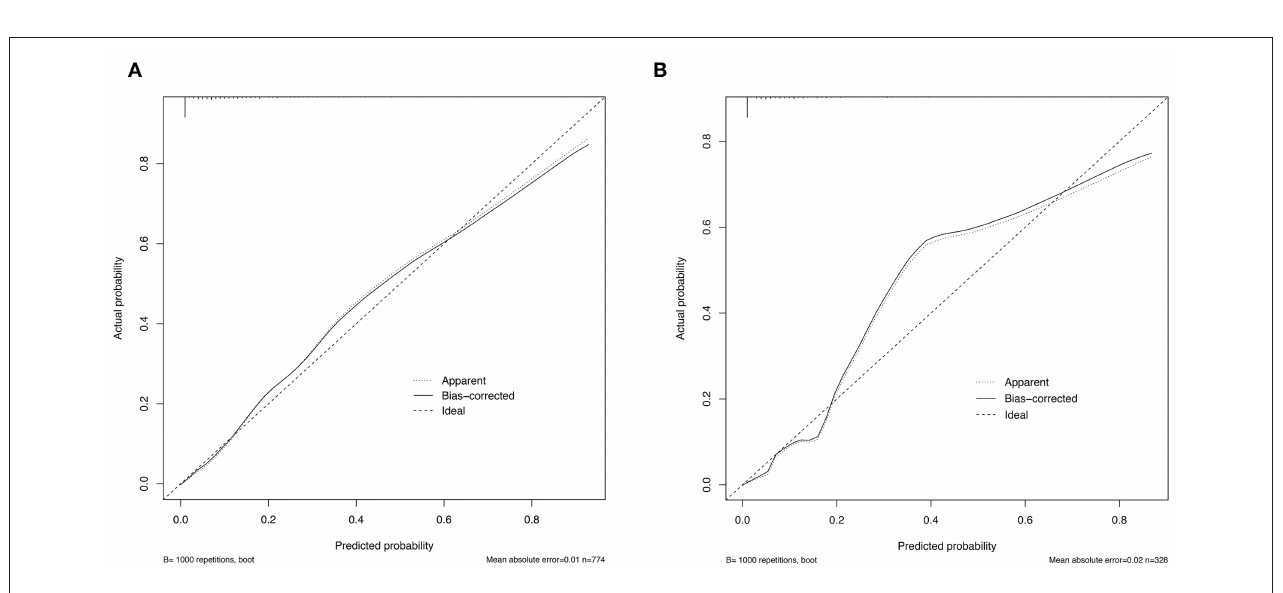
FIGURE 5 | The nomogram for predicting the risk of lymph node metastasis in patients with NSCLC ≤ 2cm, based on six clinicopathological variables (tumor size, CEA, histological type, imaging density, LVI, PI). CEA, carcinoembryonic antigen; ADC, adenocarcinoma; pGGN, pure ground glass nodule; mGGN, mixed GGN; SN, solid nodule; LVI, lymphovascular invasion; PI, pleural invasion.